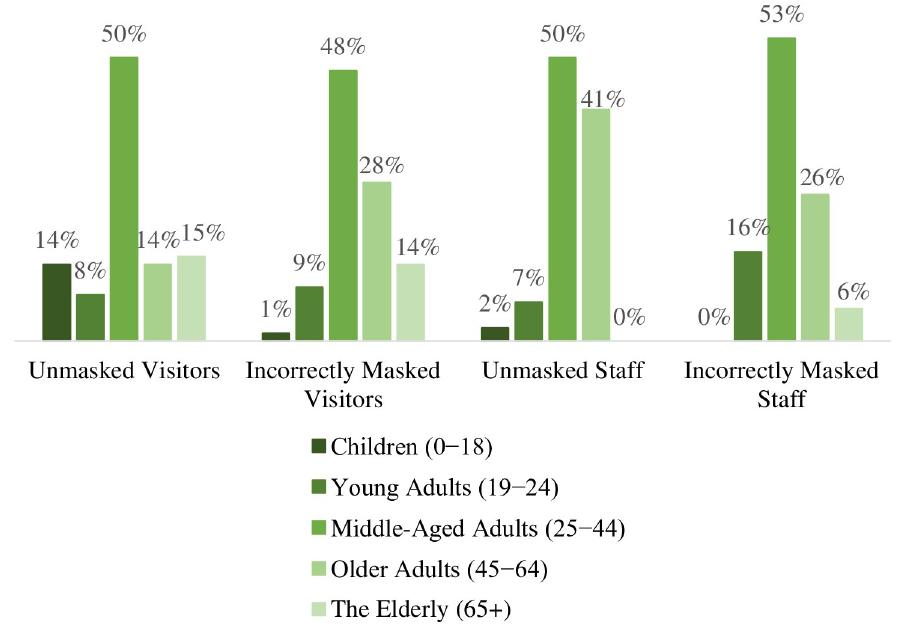
Fig 5. The age distribution of the unmasked and incorrectly masked among visitors and